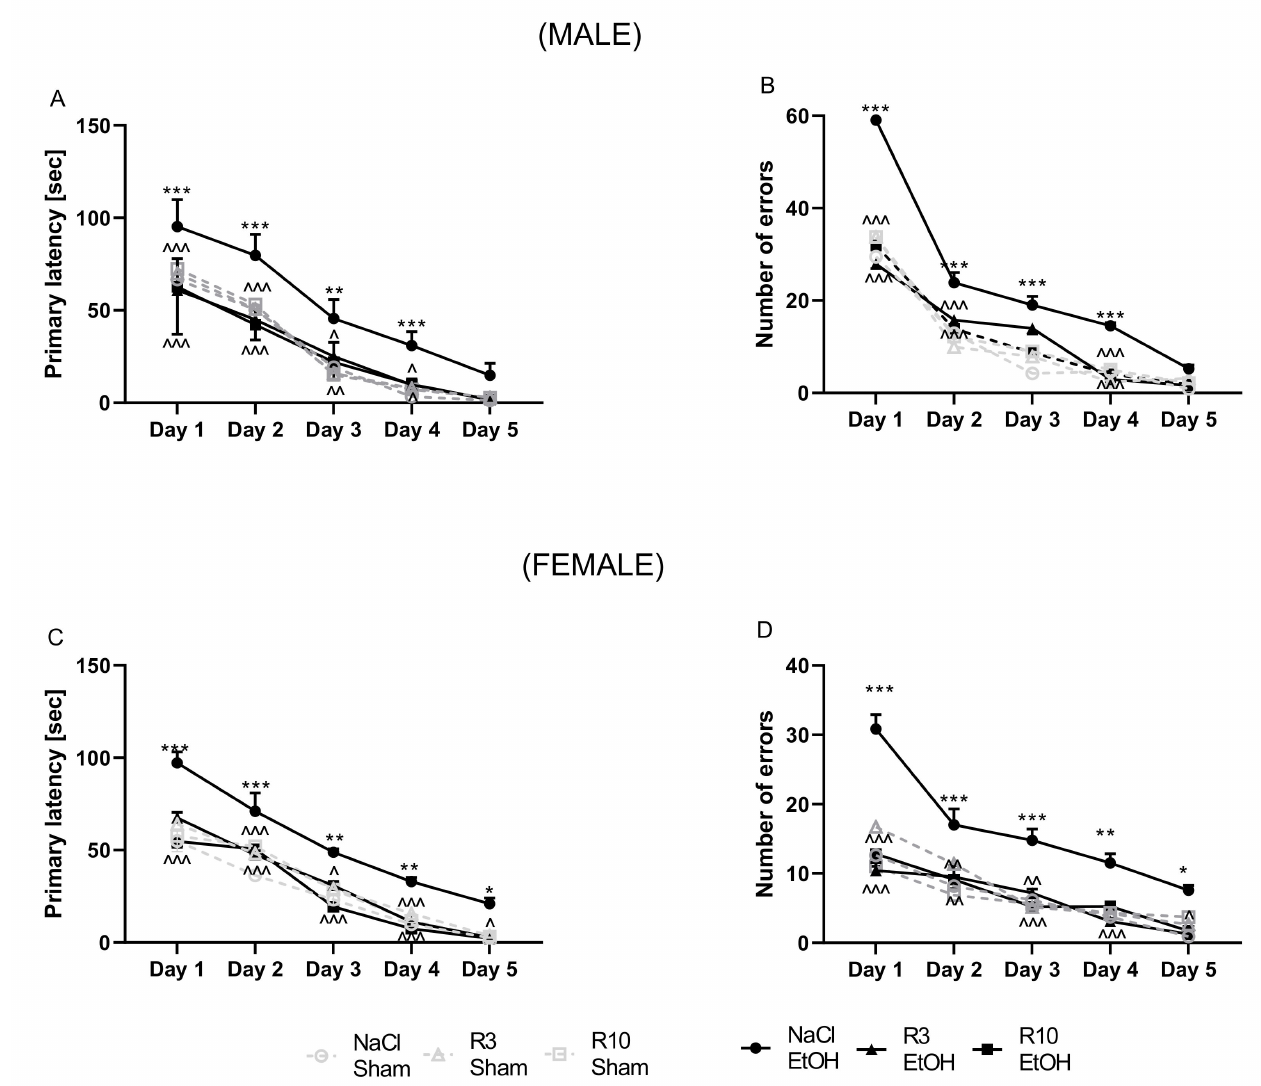
Figure 2. The influence of rapamycin pre-treatment (3 and 10 mg/kg, i.p.) during neonatal period before every ethanol administration (PND4–9) on the acquisition learning impairments in adult (PND61–65) male and female rats in the Barnes maze task. Primary latency ( A , C ) and number of errors ( B , D ) are expressed as mean ± SEM of 8 subjects per group (R 3.6.0. for Windows). * p < 0.05; ** p < 0.01 *** p < 0.001 vs. SI; ˆ p < 0.05; ˆˆ p < 0.01; ˆˆˆ p < 0.001 vs. EtOH. R3–rapamycin 3 mg/kg; R10–rapamycin 10 mg/kg, SI–shame intubation (i.g.); EtOH–ethanol intubation